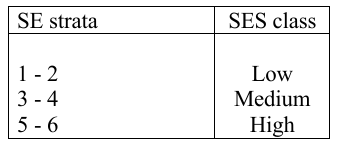
Table 1. Reclassification of strata to SES class.